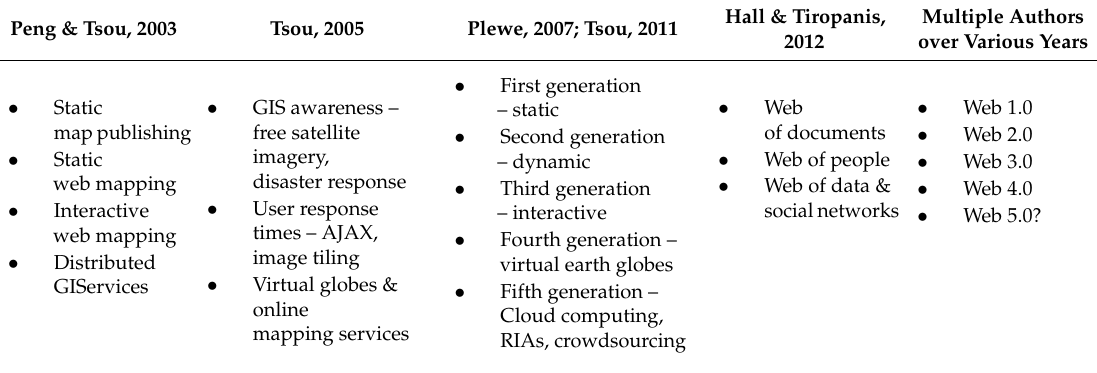
Table 1. Previously characterized eras of web mapping (Adapted from